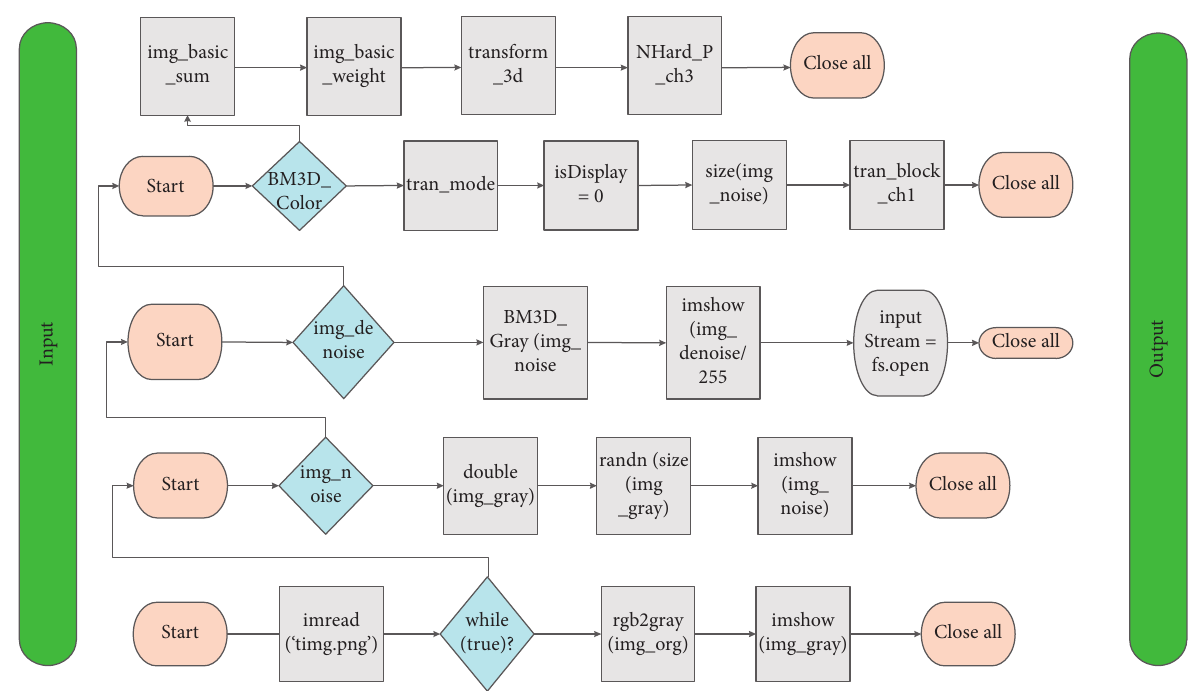
Figure 2: Public policy-public opinion system forecast algorithm